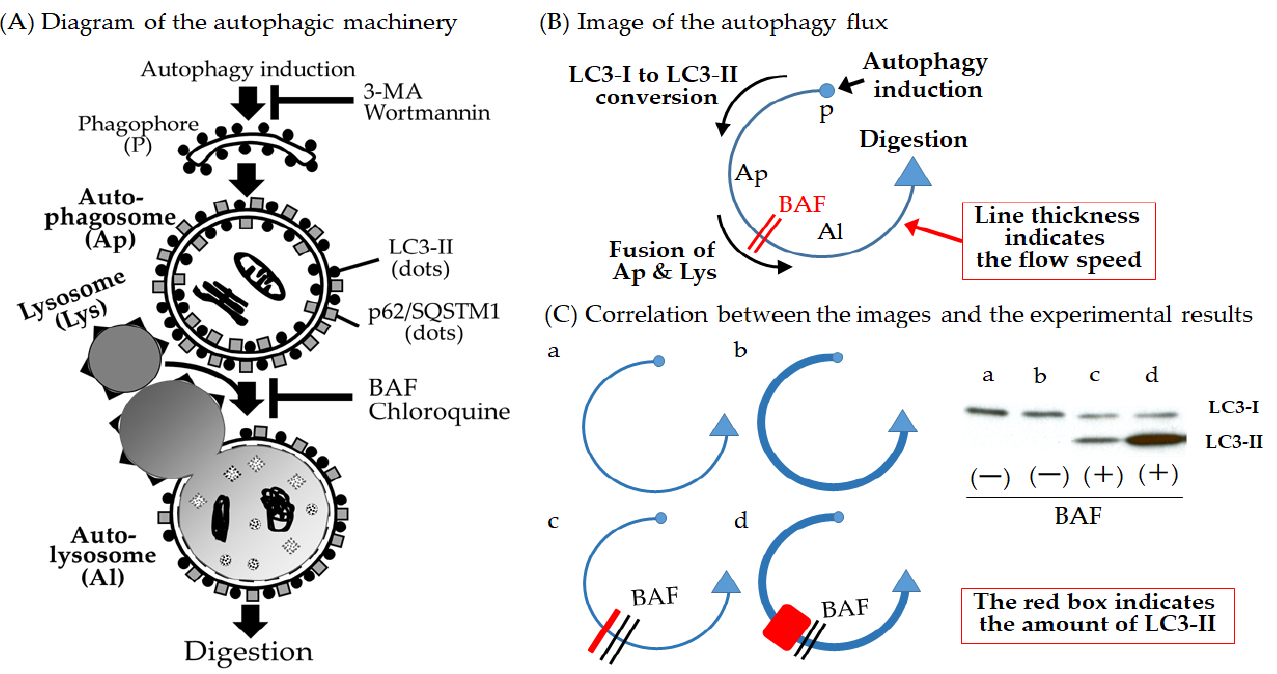
Figure 1. Diagrammatic autophagy. ( A ) Diagram of the autophagic machinery. ( B ) Three-quarter circle image of the autophagy flux. Autophagy constantly flows in the cells. The line thickness indi- cates the flow speed. ( C ) The imaged experimental results. The three-quarter circle images indicate “Low autophagic flow” (a, c) and “High autophagic flow” (b, d). The indicated Western blotting image shows an ideal result. The image was obtained from HchEpC1b cells, a trophoblast-derived cell line, which were cultured in DMEM/10% FBS (a, c) or DMEM/0% FBS (b, d) with (c, d) or without (a, b) BAF. As LC3-II, but not LC3-I can be visualized with BAF, the amount of LC3-II (red boxes) ± lysosomal inhibitors indicates the autophagy flux. P: phagophore; Ap: autophagosome; Lys: lyso- somes; Al: autolysosomes. BAF: bafilomycin A1.